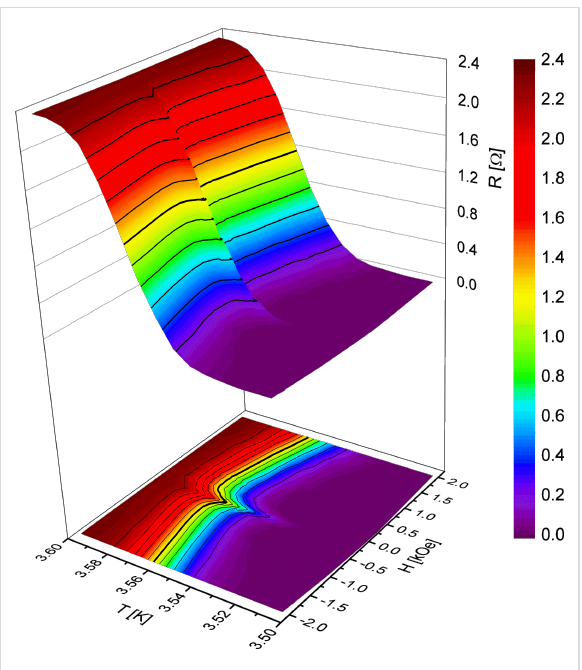
Figure 5: Superconducting transition as a function of the temperature, T , and the applied magnetic field, H , parallel to the film plane, ob- tained by four-probe measurements on sample SF 1 NF 2 -AF1#17 at a measuring current of 10 μ A, both as 3D plot and planar projection. The applied magnetic field was varied from positive to negative values. The solid lines represent certain resistance levels, the bold line indicates roughly the level, where we evaluated the transition temperature, T c , at half of the normal-state resistance.